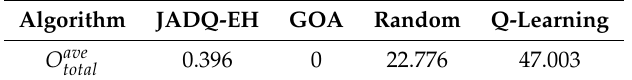
Figure 7. O total comparison of different algorithms under scenario 1. Table 5. O ave comparison of different algorithms under scenario total